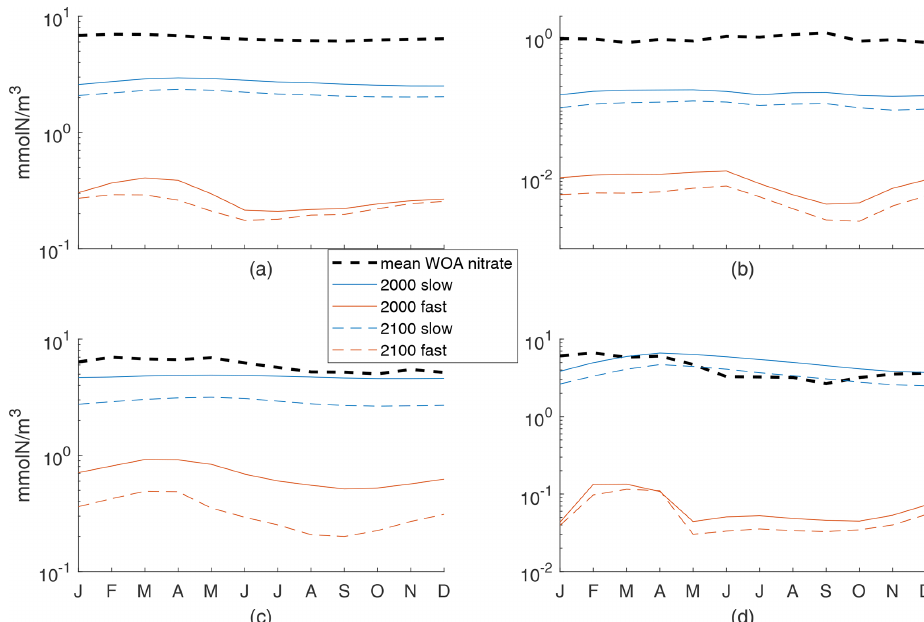
Figure A1. Mean of monthly 100m averaged WOA nitrate concentrations and the monthly 100m averaged mean N concentrations for both fast and slow cases in 2000s and 2100s conditions. (a) Global ocean, with 6-month offset for the Southern Hemisphere, (b) subtropical South Pacific, (c) Arctic, and (d) Porcupine Abyssal Plain. Note that the y axis is a log scale.